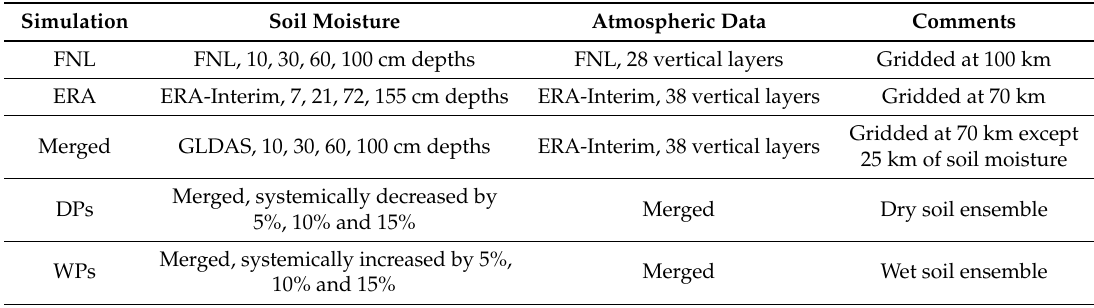
Table 1. List of numerical simulations. More detailed descriptions are found in Section